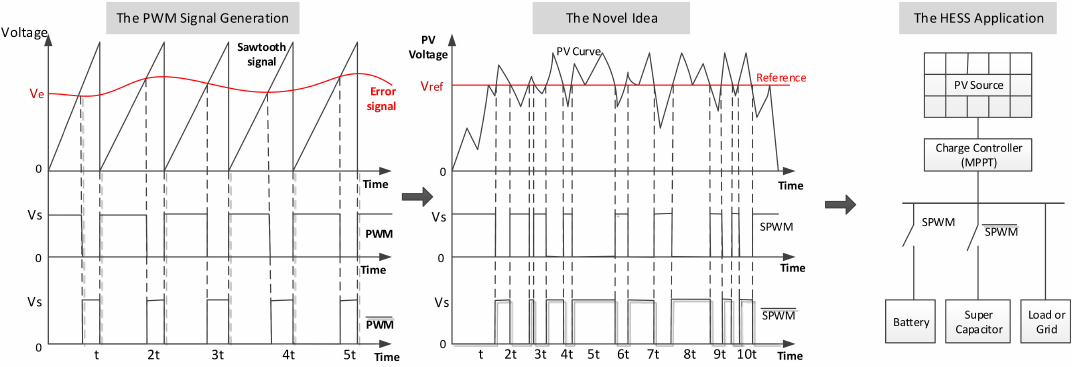
Figure 3. The proposed new topology and control of the passive HESS.